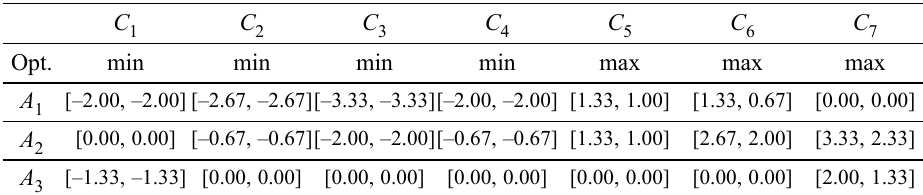
Table 7. Distances from alternatives to the grey ideal point, in relation C 1